Question: What type of chart is this?
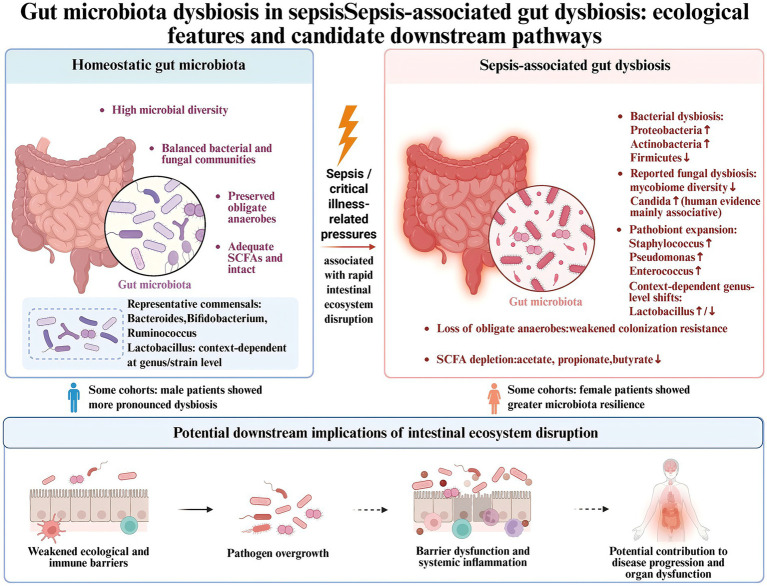
Answer: line